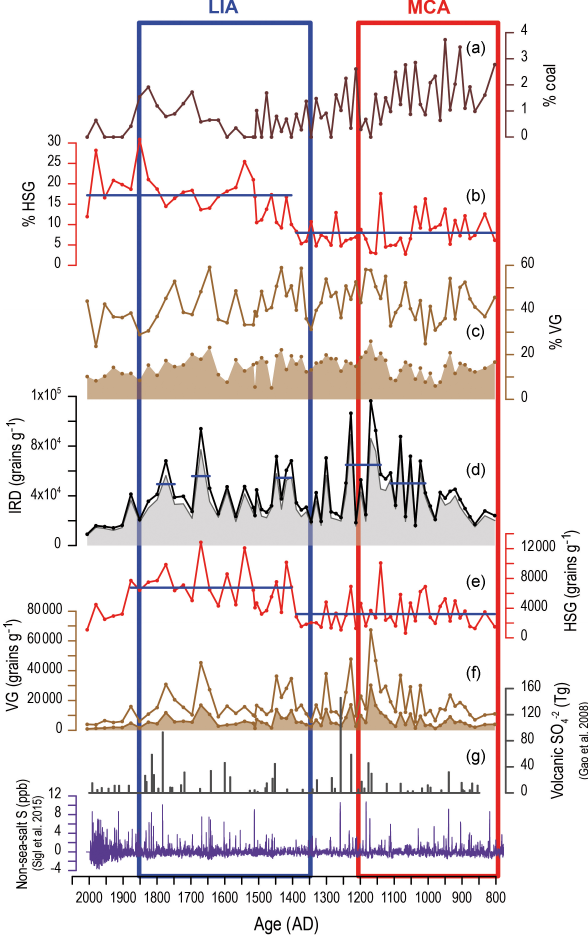
Figure 2. Ice-rafted debris (IRD) records from site GS06-144- 03. (a) Coal grains relative abundance; (b) hematite-stained grains (HSGs) relative abundance; (c) total volcanic glass (VG) relative abundance (brown line) and white VG relative abundance (shaded area); (d) total IRD concentration in each sediment sample (black line), and IRD concentration not including the white volcanic glass (shaded area); (e) concentration of HSGs; (f) concentration of to- tal VG (brown line) and white VG (shaded area); and (g) Northern Hemisphere sulphate aerosol injection by volcanic eruptions (after Gao et al., 2008, revised in 2012) and non-sea-salt sulfur from the NEEM Greenland ice core (Sigl et al., 2015). Blue horizontal lines indicate mean values for the intervals they encompass. The approx- imate standard duration of the Little Ice Age (LIA) and Medieval Warm Period (MWP) has been depicted in blue and red squares re-